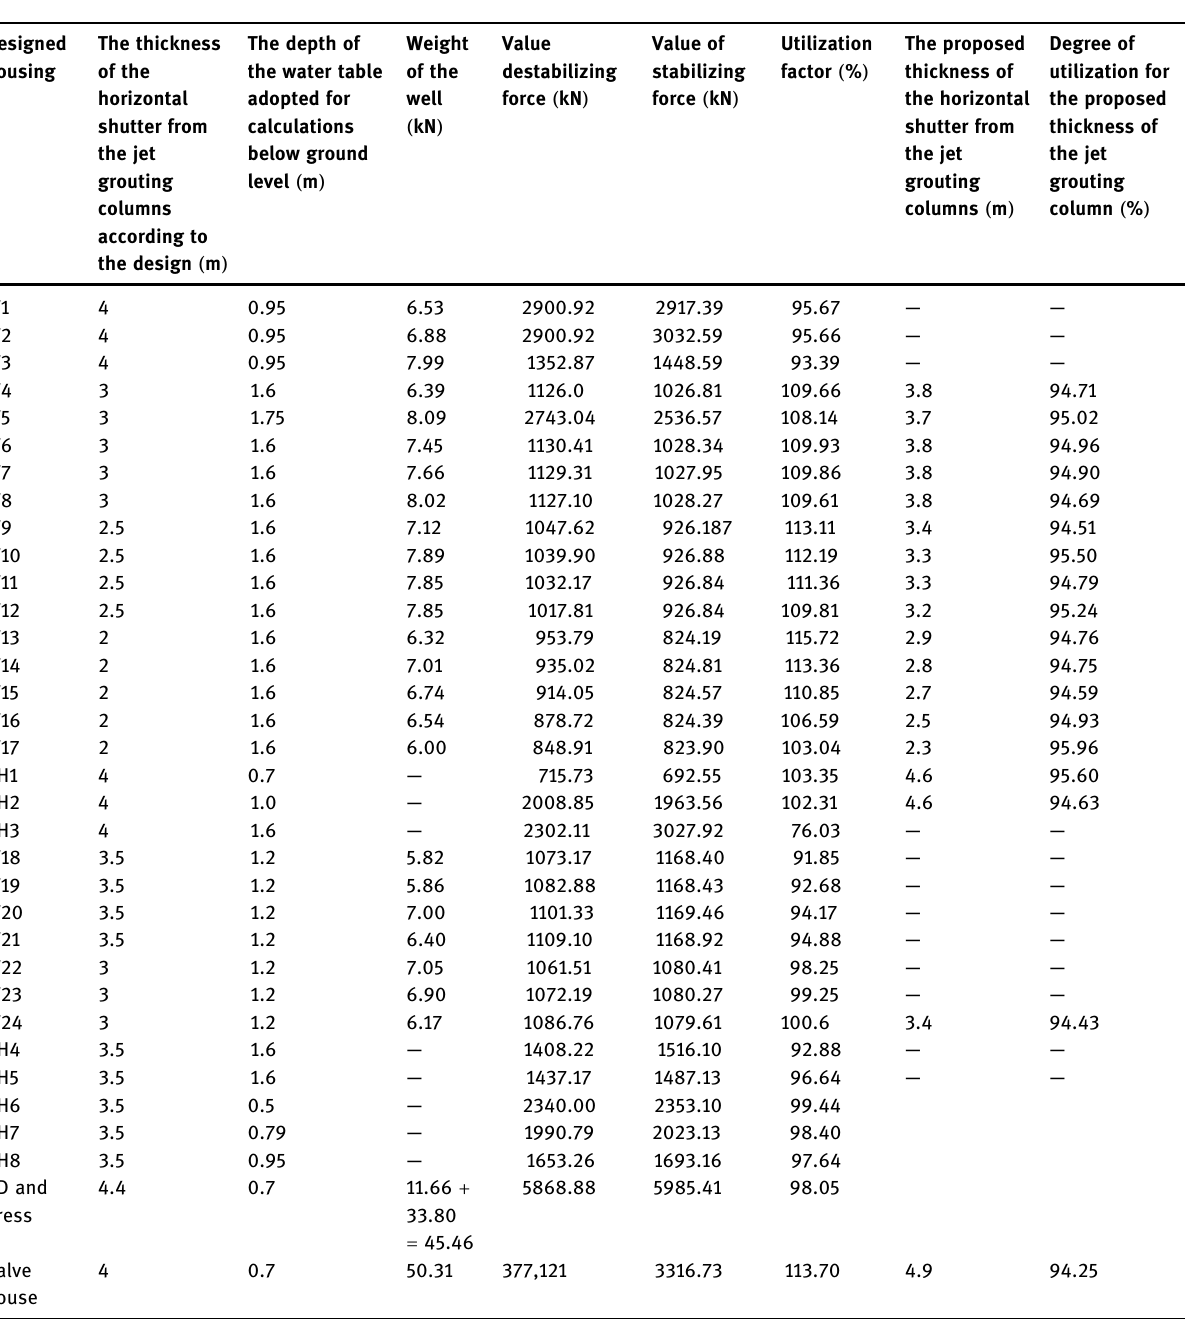
Table 2: Data summary and results of UPL limit state calculations Designed